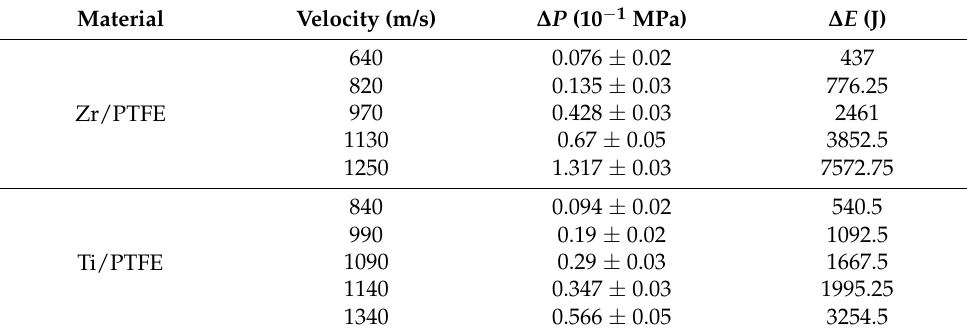
Table 2. Calculation results of the energy released by